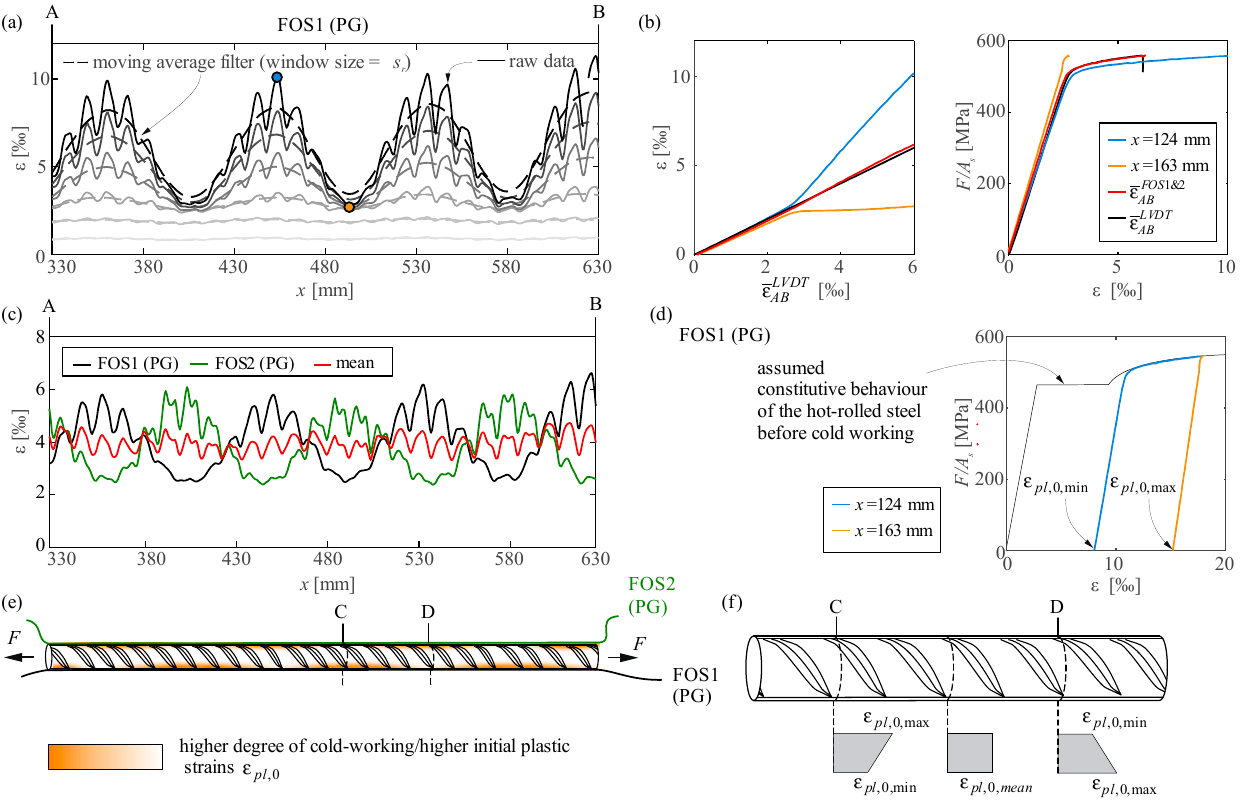
Figure 7. Cold-worked reinforcing bar cw02 tested under direct tension: ( a ) Strain distribution of FOS1 at selected load steps; ( b ) comparison of local strains at marked points to mean strains of LVDT and FOS over AB , and resultant stress–strain behaviour; ( c ) strains distributions of FOS1&2 and their average for a 4‰ mean; ( d ) qualitative explanation of different local stress–strain behaviour with initial strains; ( e ) uneven cold-working degree and ( f ) qualitative distribution of local initial strains ( ε pl ,0 ).